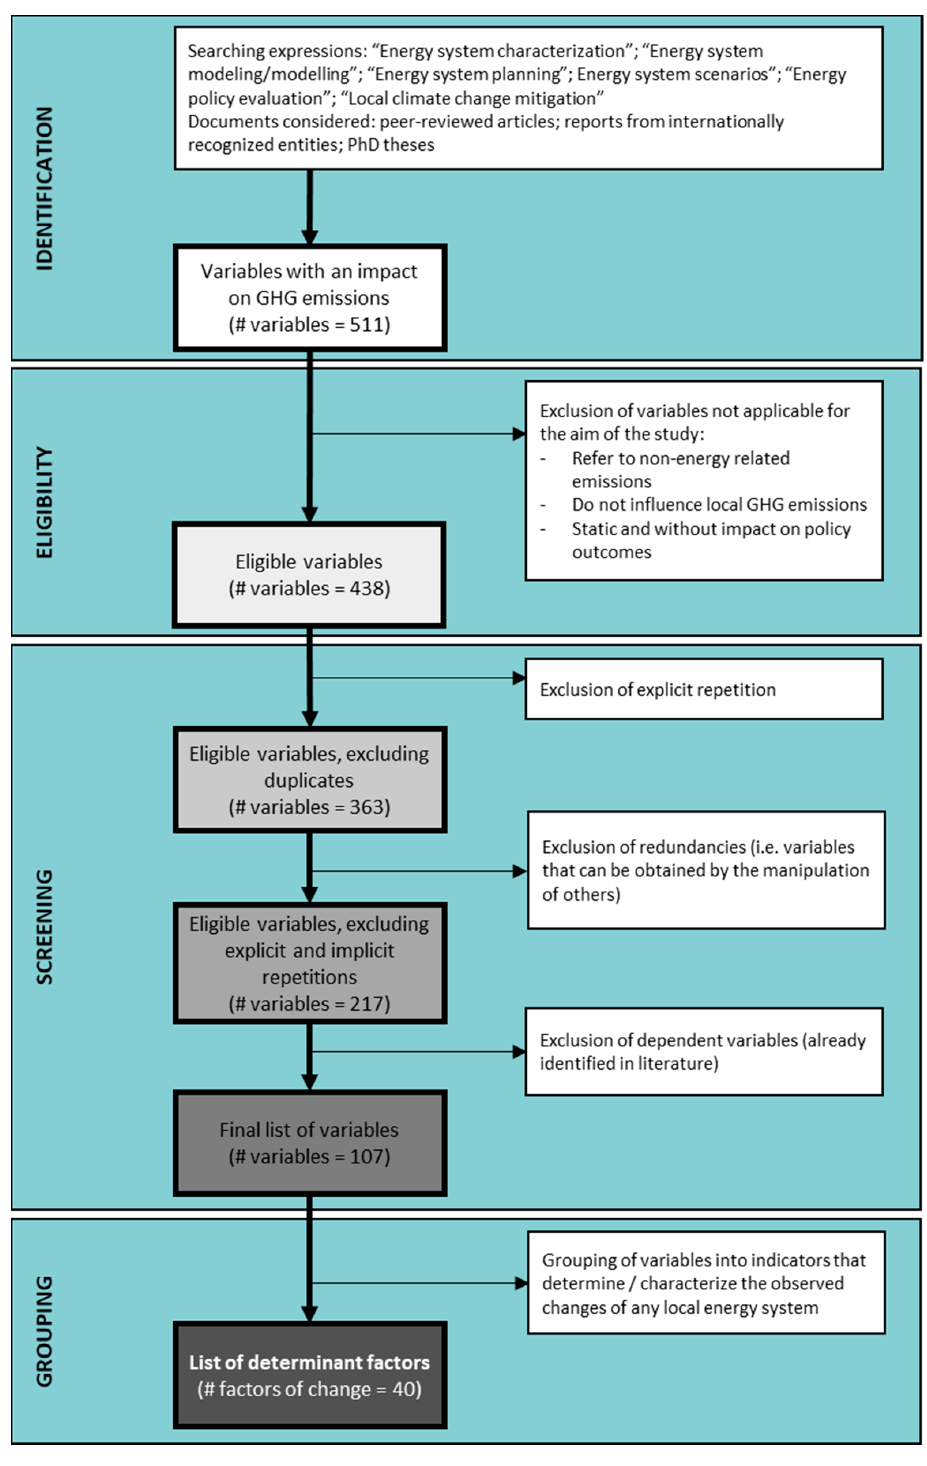
Figure 1. Schematic representation of the systematic literature review process.